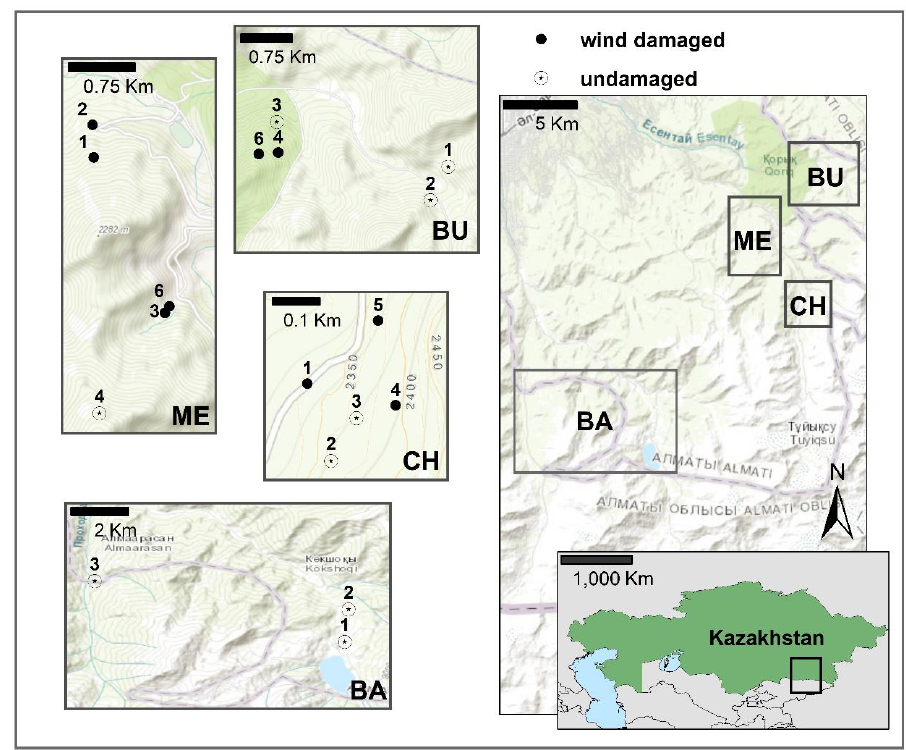
Figure 1. Study site locations in southeast Kazakhstan. Study site locations in the Tien Shan Mountains are on the right, with the inset showing the general location in Kazakhstan. Plot locations within each study area are on the left: BA1, 2 and 3 are Bolshaya Almatinka, BU1-4 and 6 are Butakovka Valley, CH1-5 are Chimbulak, and ME1-4 and 6 are Medeu Ski Valley.